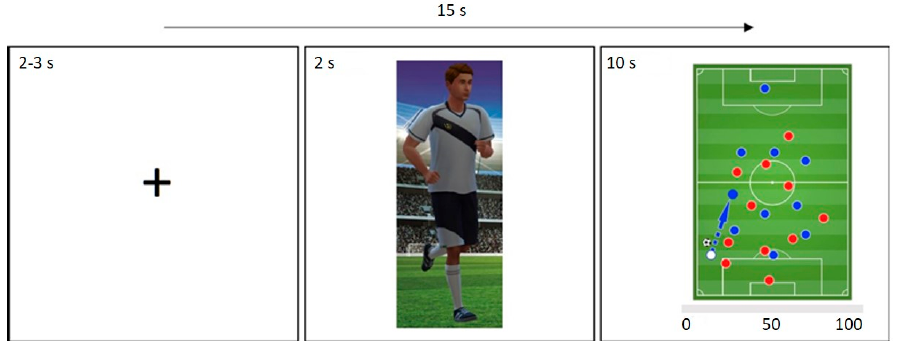
Figure 1. Illustration of an experimental trial. At the start of each trial, a fixation cross was presented for a duration of 2 to 3 s (variation due to jittering). Next, a player representing the self, rival, in-group, or out-group was displayed for 2 s. Subsequently, a soccer game scenario was presented for 10 s; in this latter phase, our participants estimated the likelihood for a successful pass (rating range 0–100%).